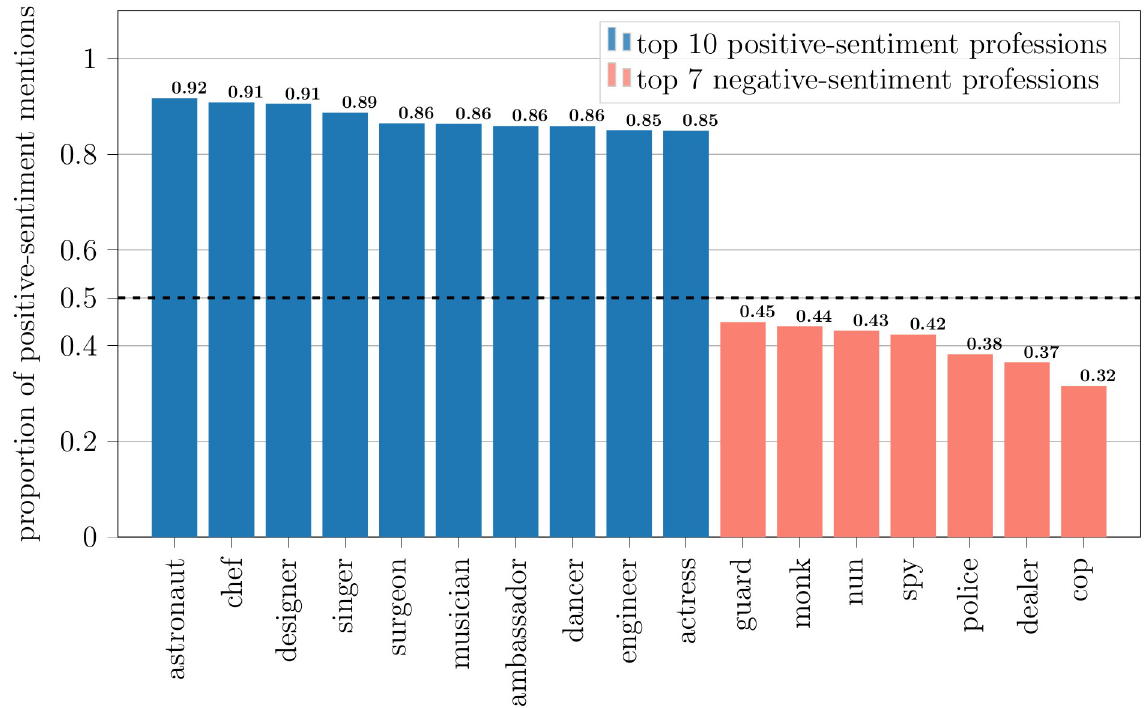
Fig 11. Top 10 positive-sentiment and top 7 negative-sentiment professions. The blue-colored professions have the top 10 highest proportion of positive sentiment mentions. The red-colored professions have the top 10 highest proportion of negative sentiment mentions.